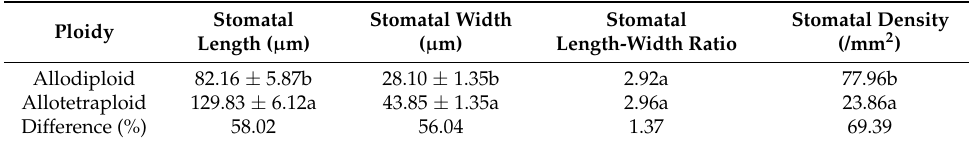
Table 2. Leaf anatomical structure of allodiploid and allotetraploid Lilium FA hybrids.